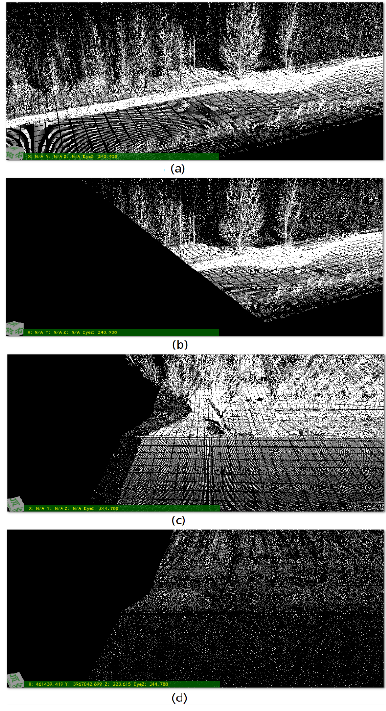
Figure 8. Segment end processing of vehicle-borne laser point